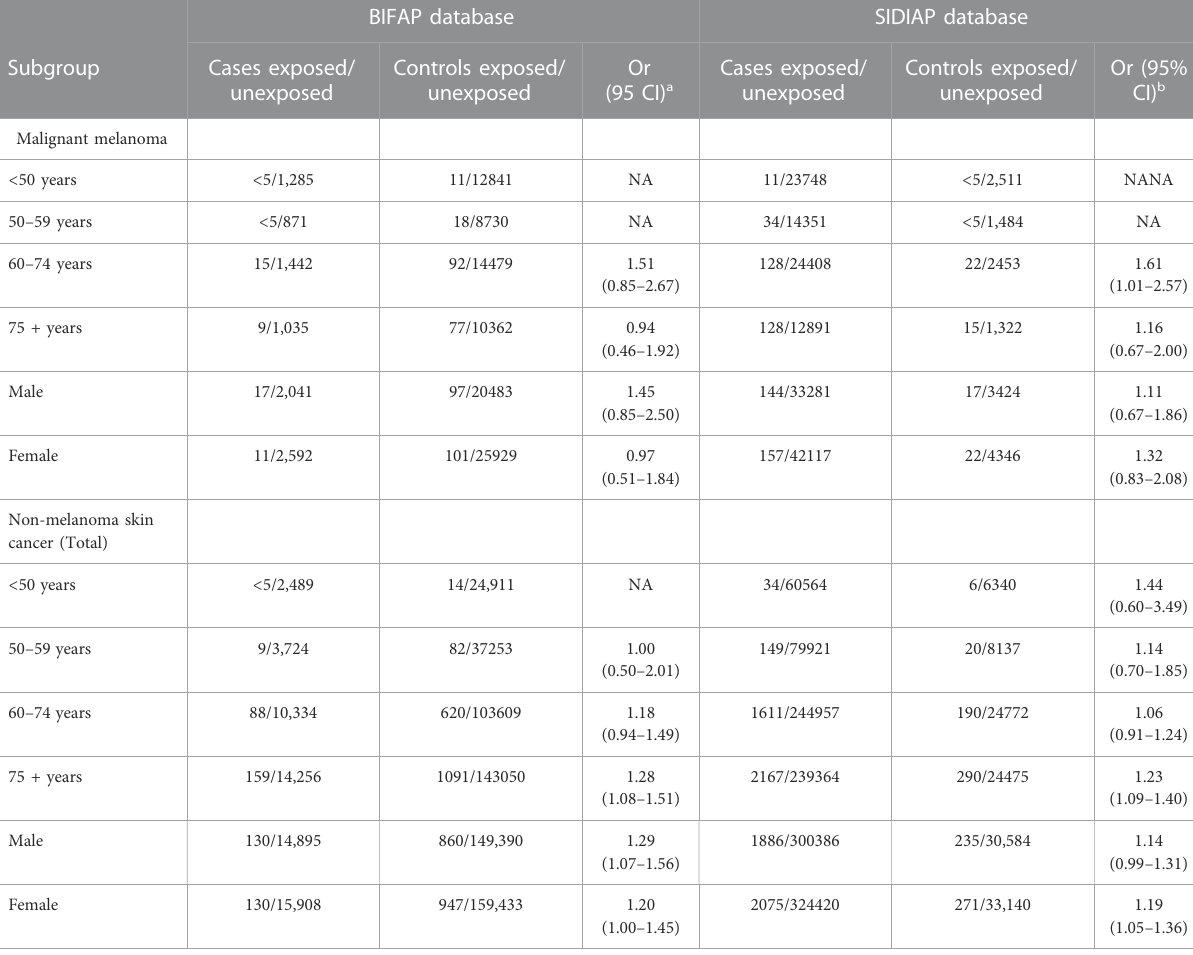
TABLE 3 Association between ever-use of fl ecainide and risk of skin cancer, according to patient subgroups in the Spanish databases (SIDIAP and BIFAP). Reference: Never-users of fl ecainide in each subgroup (unexposed). BIFAP